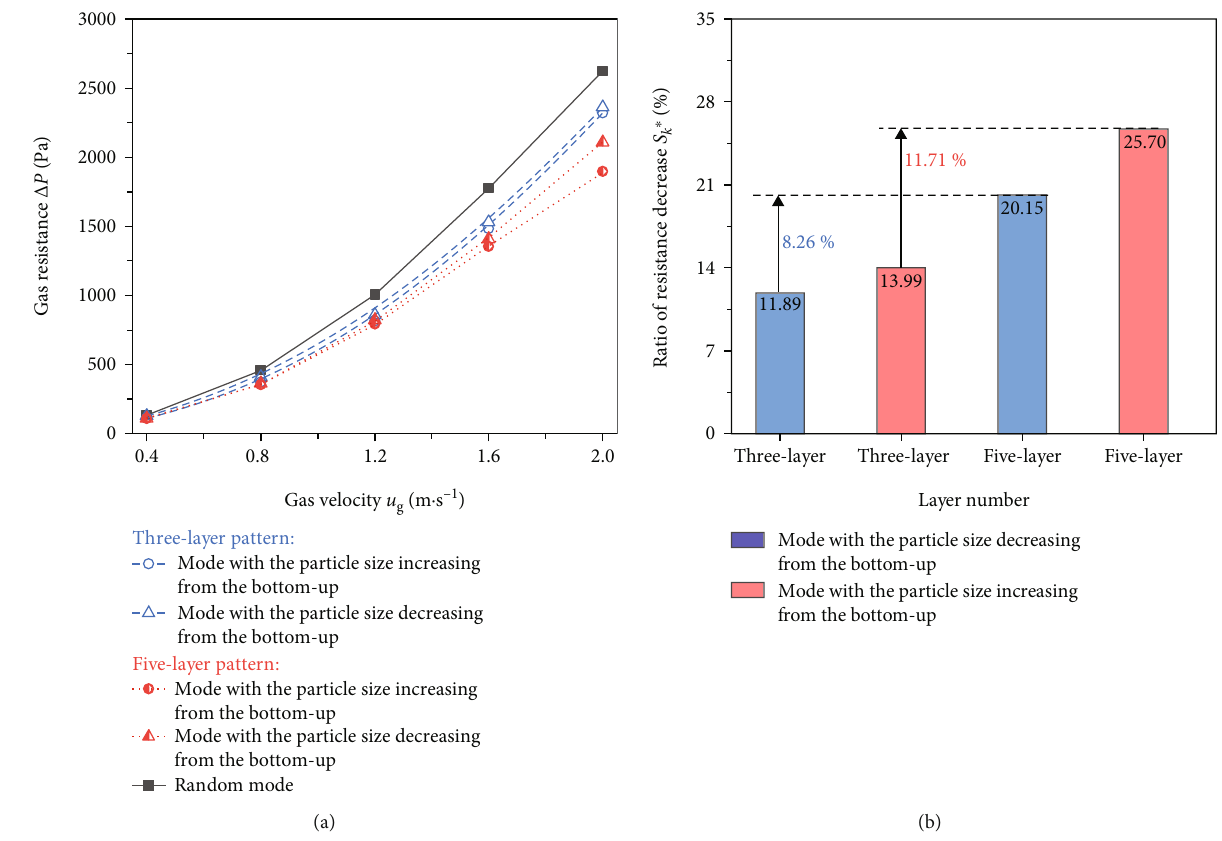
Figure 12: The e ff ect of the layer number on the gas fl ow resistance of the sinter mixture with the equivalent particle diameter of 11.45mm: (a) the comparison of the gas fl ow resistance Δ P between two three-layer modes and two fi ve-layer modes; (b) the comparison of the ratio of the resistance decrease S k ∗ between the two three-layer models and two fi ve-layer